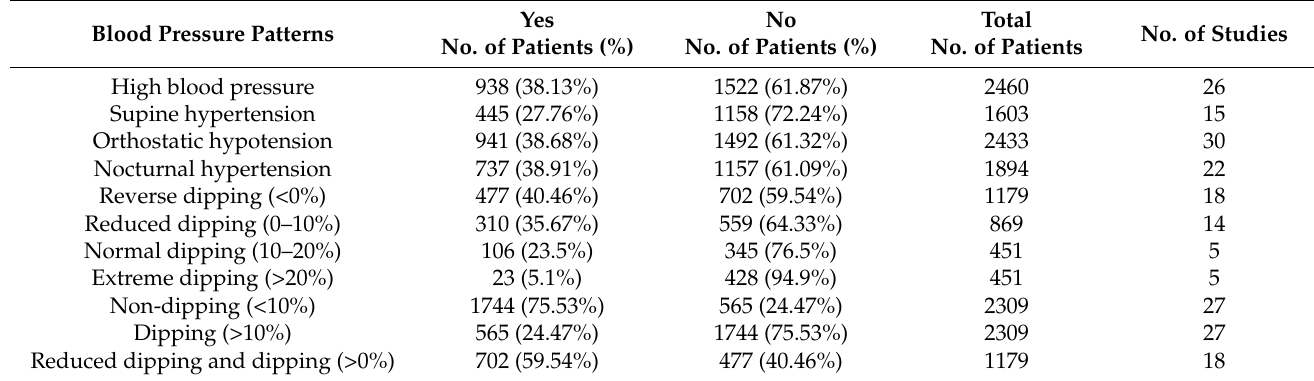
Table 2. Blood Pressure patterns in Parkinson’s Disease